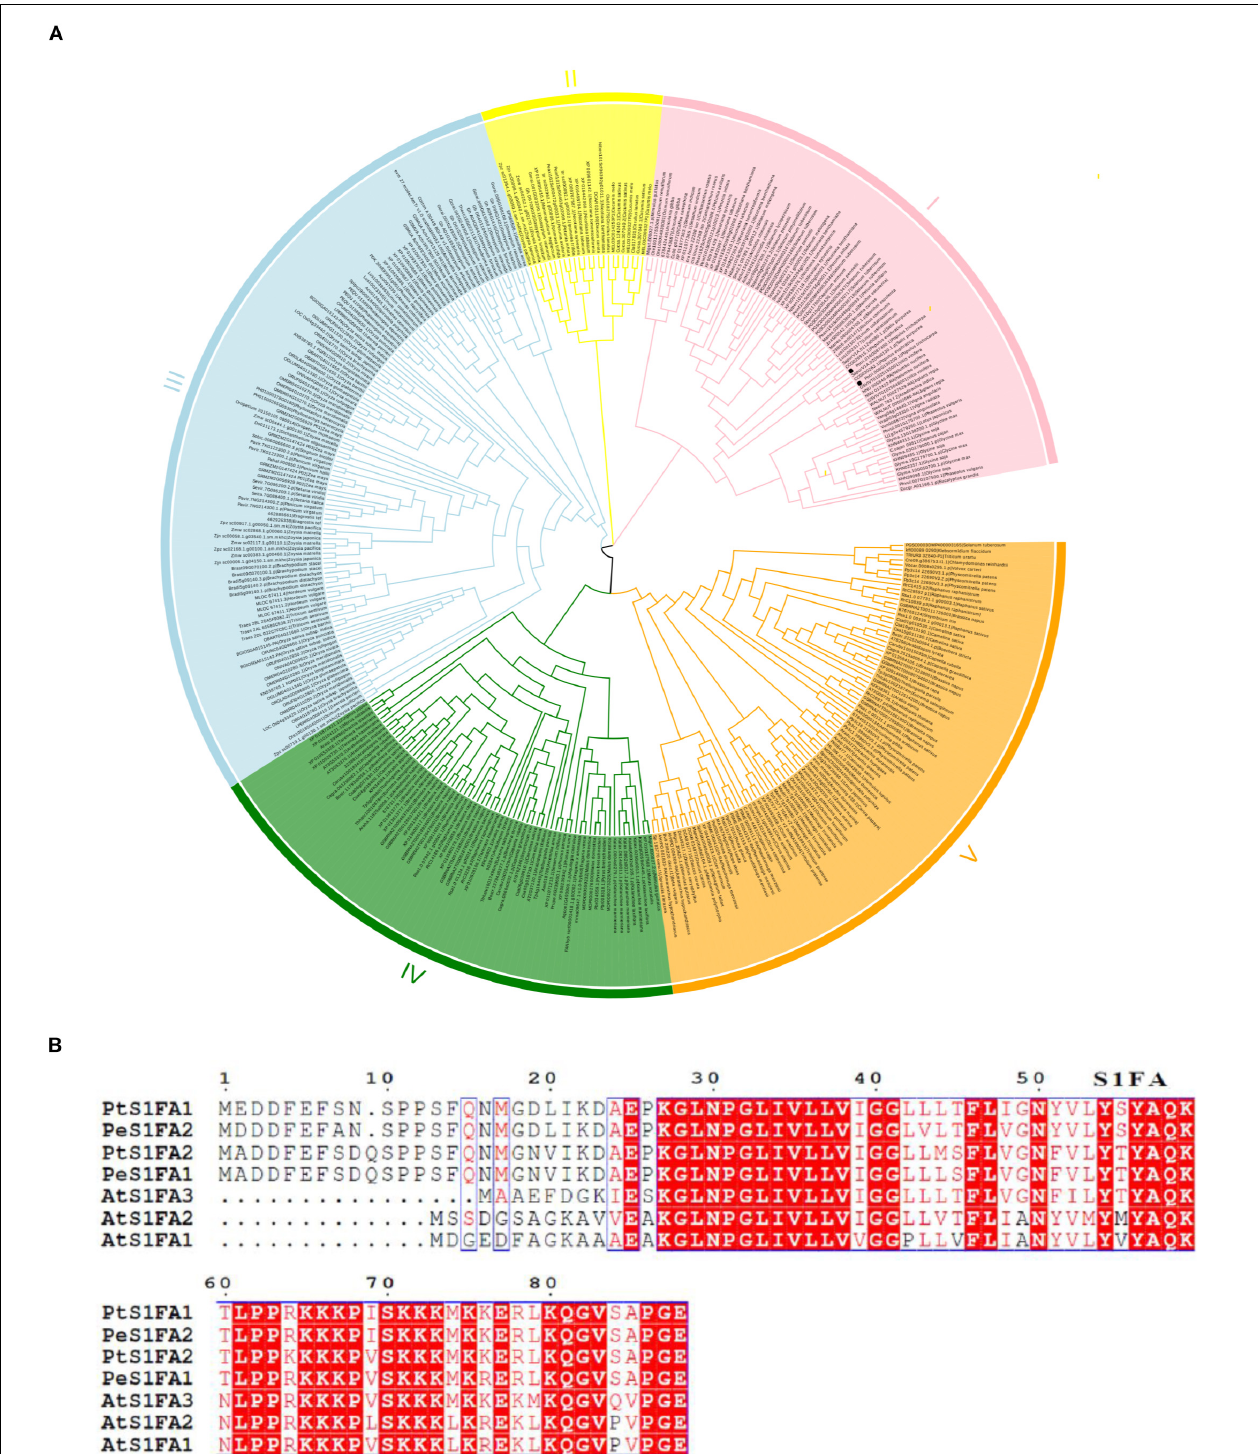
FIGURE 1 | Phylogenetic analysis and multiple sequence alignment of S1Fa-like proteins. (A) Dendrogram of the protein sequences of the S1Fa-like gene family from some species with known genome. The dendrogram was constructed using MEGA version 7 software and using the method of neighbor-joining (NJ). Each special class is present by one color. (B) Multiple sequence alignment of S1Fa proteins from Populus trichocarpa , Arabidopsis , and P. euphratica . Multiple sequence alignment was performed using MEGA version 7 software. The amino acid with red background were highly conserved, and amino acid with red were conserved.